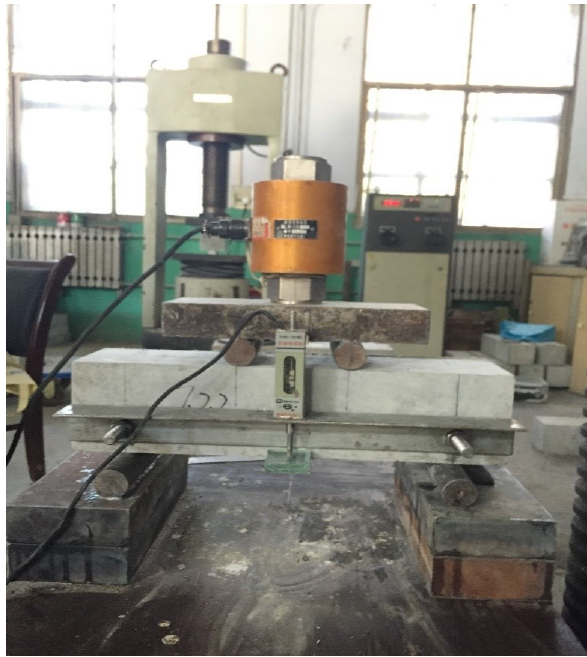
Figure 1: Data collection of bending test